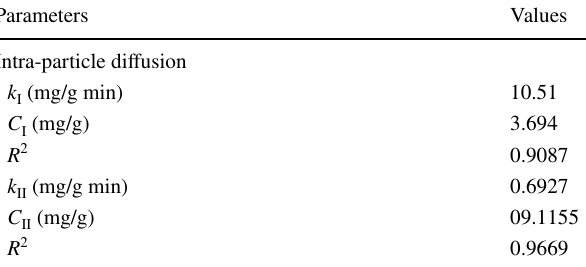
Table 6 Weber–Morris parameters of adsorption of pyrene Parameters Values Intra-particle diffusion